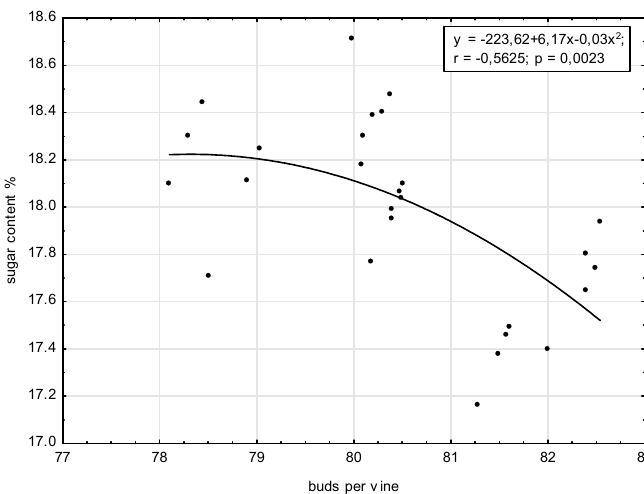
Agronomy 2020 , 10 , x FOR PEER REVIEW Figure 3. The e ff ect of bud number on sugar content in grapes. Figure 3. The effect of bud number on sugar content in grapes. Figure 3. The effect of bud number on sugar content in grapes.